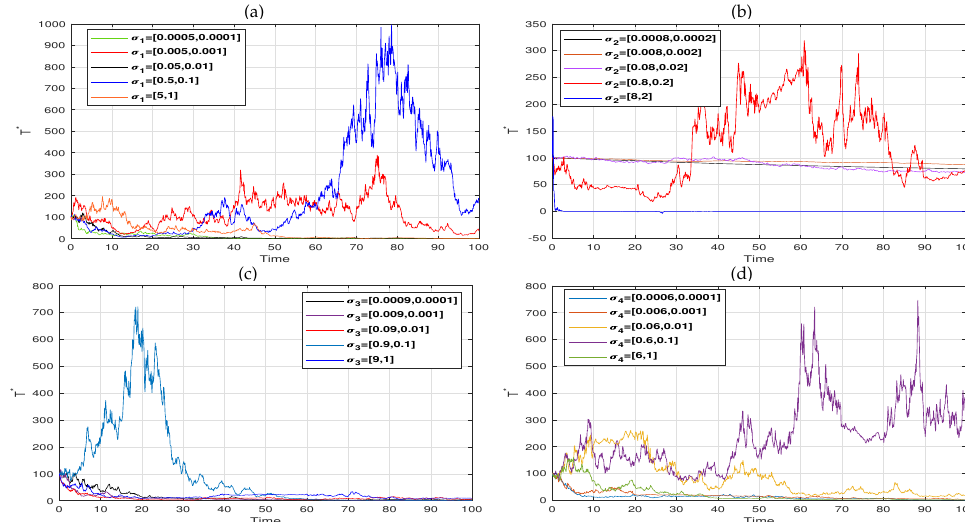
Figure 5. The effect of noise intensity σ 2 ( i = 1, · · · ,4) on the evolution of infected cells T ∗ ( t ) of i model (2): ( a ) the effect of σ 1 ; ( b ) the effect of σ 2 ; ( c ) the effect of σ 3 ; ( d ) the effect of σ 4 . The intensities of σ 3 and σ 4 have very important impacts on the evolution of the virus; they lead to the elimination of the virus. The other perturbations ( σ 1 and σ 2 ) have a relatively small